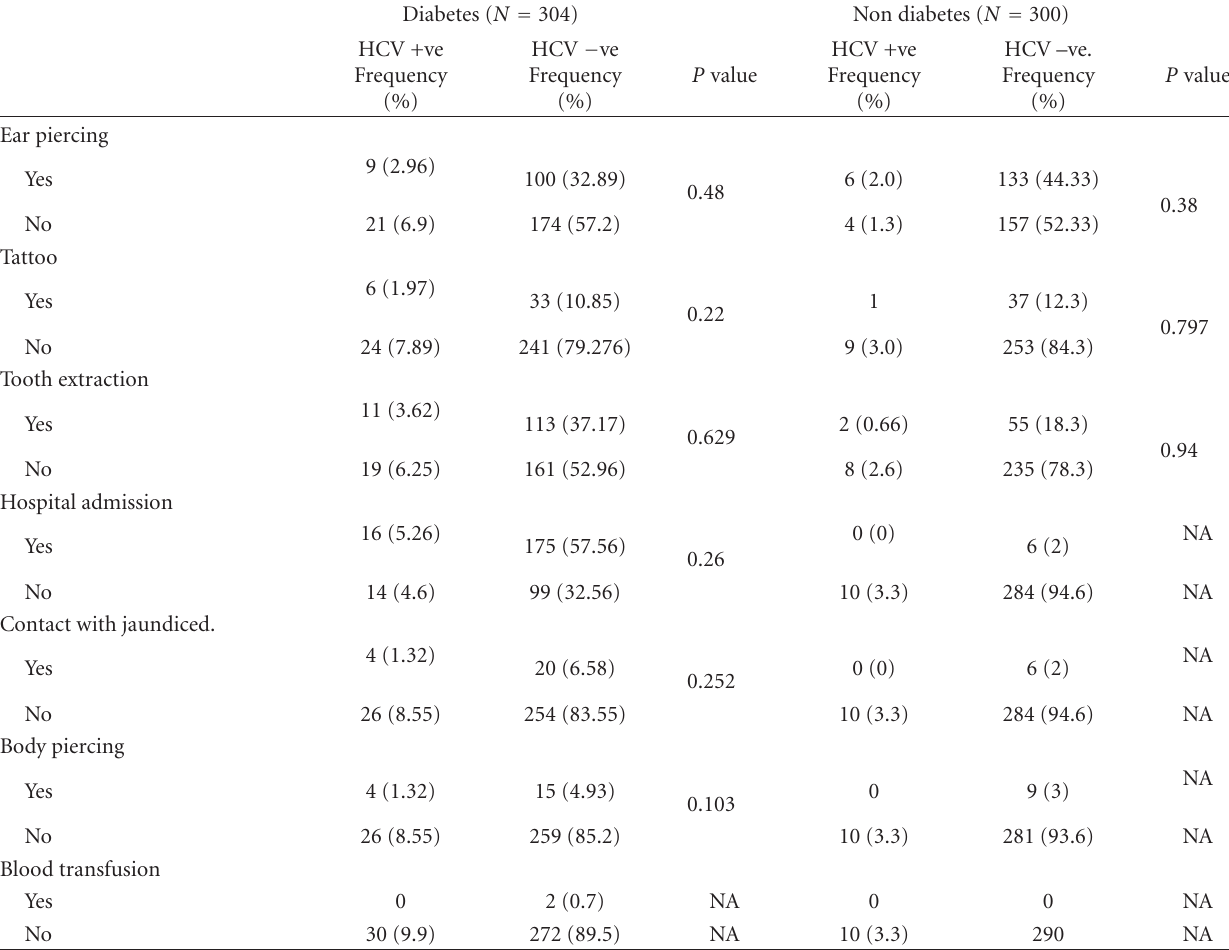
Table 2: Frequency distribution of HCV risk factors between diabetic and non diabetic controls at Jimma University Specialized Hospital, July 2010.